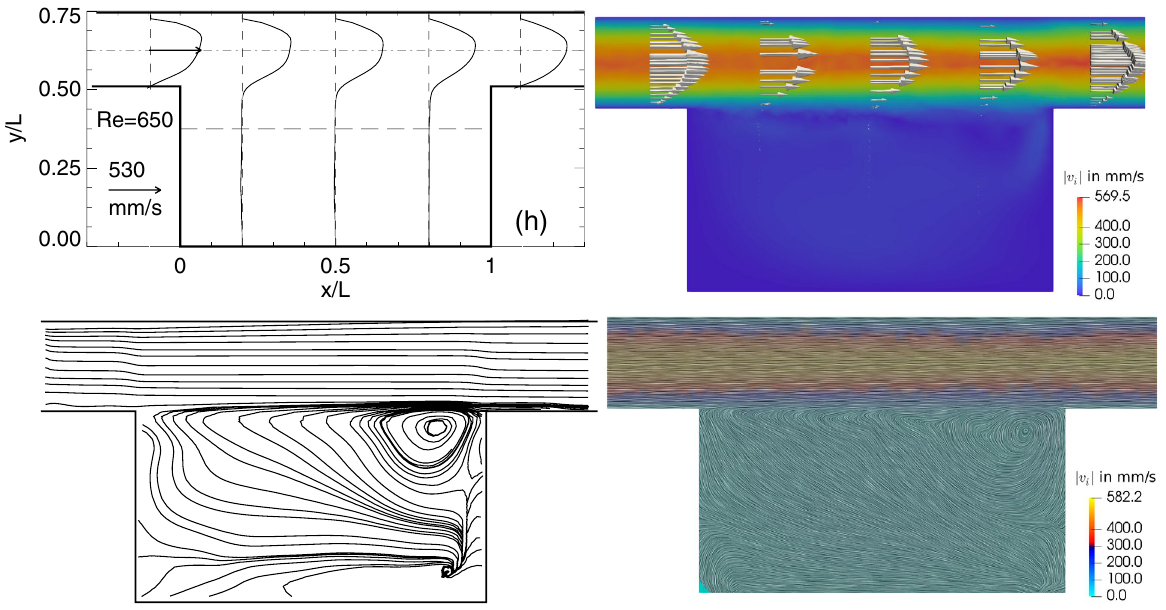
Fig. 13 Comparison of measurement and calculations: Case (h) PIV left column and CFD right column. Selected velocity profiles (top row) and streamlines (bottom row) are presented